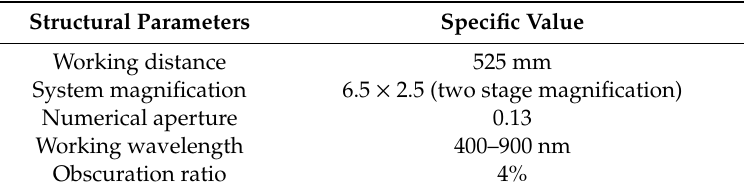
Figure 1. Schematic diagram of the focusing system of the mirror-based microscopic imaging assembly setup. assembly setup. CCD: Table 1. Parameters of microscopic imaging Table 1. Parameters of microscopic imaging system.